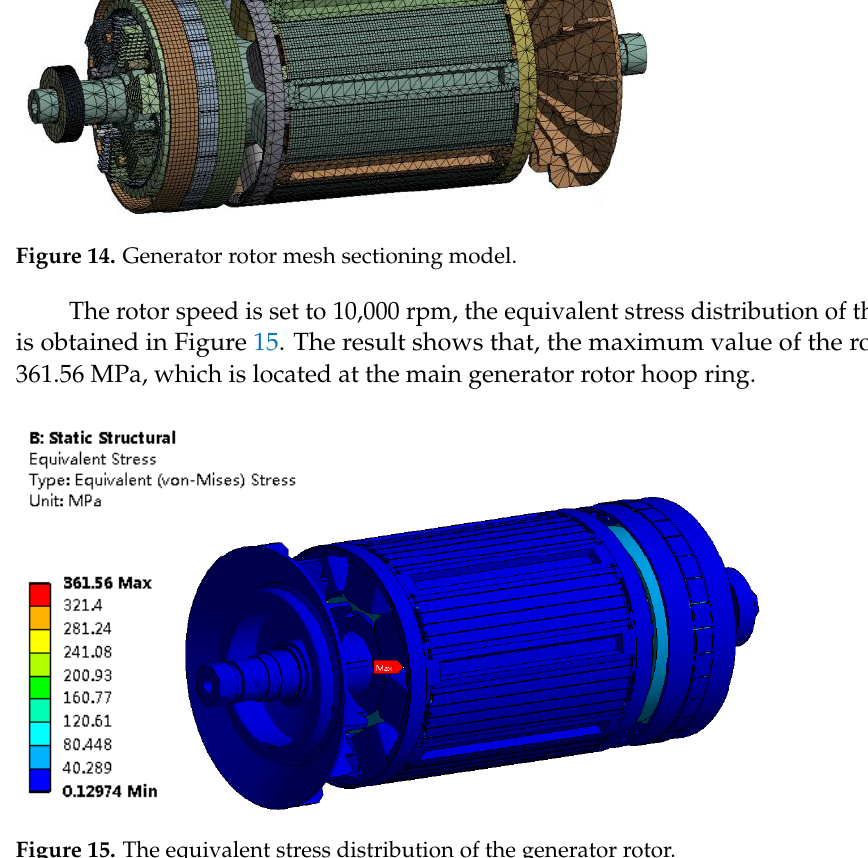
Figure 15. The equivalent stress distribution of the generator rotor.